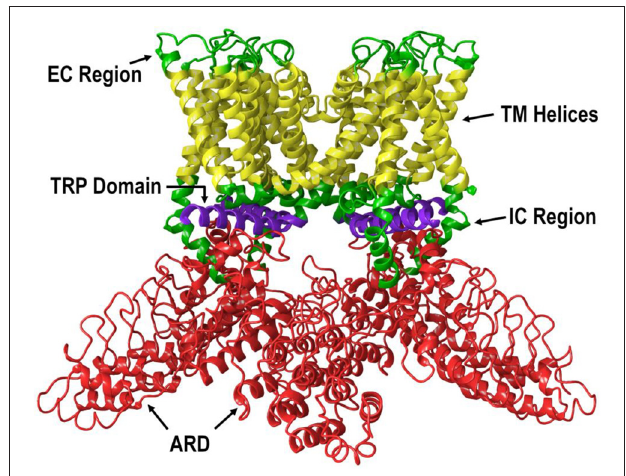
FIGURE 2 | The lipid view of TRPV1 adapted from PDB: 3J5P. Ankyrin repeat domain (ARD) shown in red, transmembrane helices shown in yellow, TRP domain shown in purple, and intracellular regions (ICRs) and extracellular regions (ECRs) shown in green. Sections have been omitted for